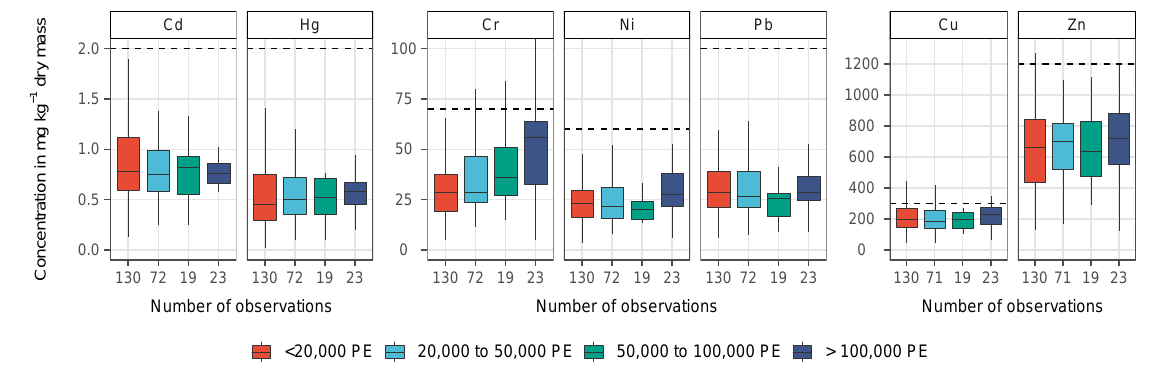
Figure 7. Heavy metal (cadmium, mercury, nickel, lead, chromium, copper and zinc) sewage sludge concentrations in milligrams per kilogram. Dashed lines give the most common Austrian heavy metal limits for the application of sludge in agriculture [37]. Statistical values are provided in Table S12.